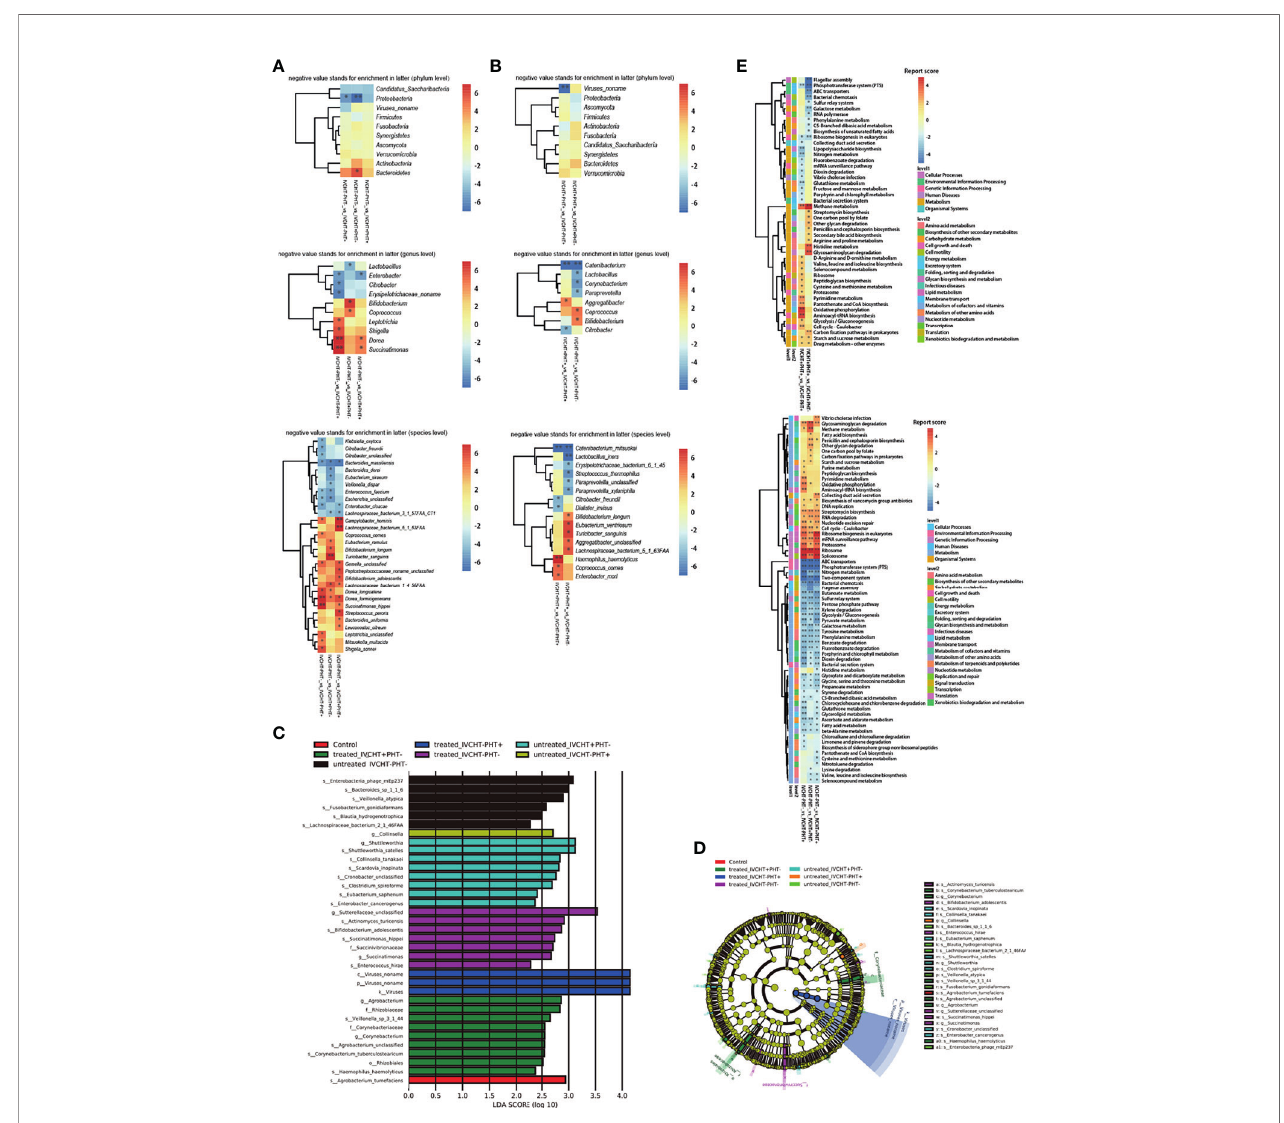
FIGURE 5 | Status of IVCHT and PHT in patients with B-CS: (A) Heat map of different levels (phyla, genus and species) between IVCHT-PHT-patients and other patients in B-CS independent of treatment. (B) Heat map of different levels (phyla, genus and species) between IVCHT+PHT+ patients and IVCHT-PHT+/IVCHT+ PHT- patients in B-CS independent of treatment. (C) Distribution of greatest differences in taxa of B-CS vs. healthy controls using LEfSe analysis were presented according to the LDA scores (log 10 ) > 2.0. (D) Evolutionary clade of B-CS different intestinal microbiota, as determined using the LEfSe method. (E) Altered microbial functions in KEGG pathway between IVCHT+PHT+ and IVCHT+PHT-/IVCHT-PHT+, IVCHT-PHT- patients and other B-CS syndrome (IVCHT-PHT+, IVCHT+PHT- and IVCHT+PHT+ patients). B-CS, Budd-Chiari syndrome; PHT, portal hypertension; IVCHT, inferior vena caval hypertension; LDA, linear discriminant analysis; KEGG, Kyoto Encyclopaedia of Genes and Genomes; LEfSe, linear discriminant analysis effective size. *P < 0.05, **P <